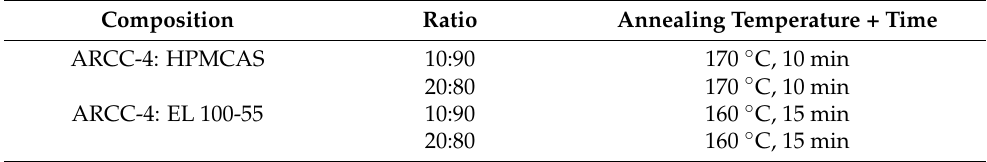
Table 1. Composition of the amorphous solid dispersions (ASDs) and the respective processing conditions. Composition